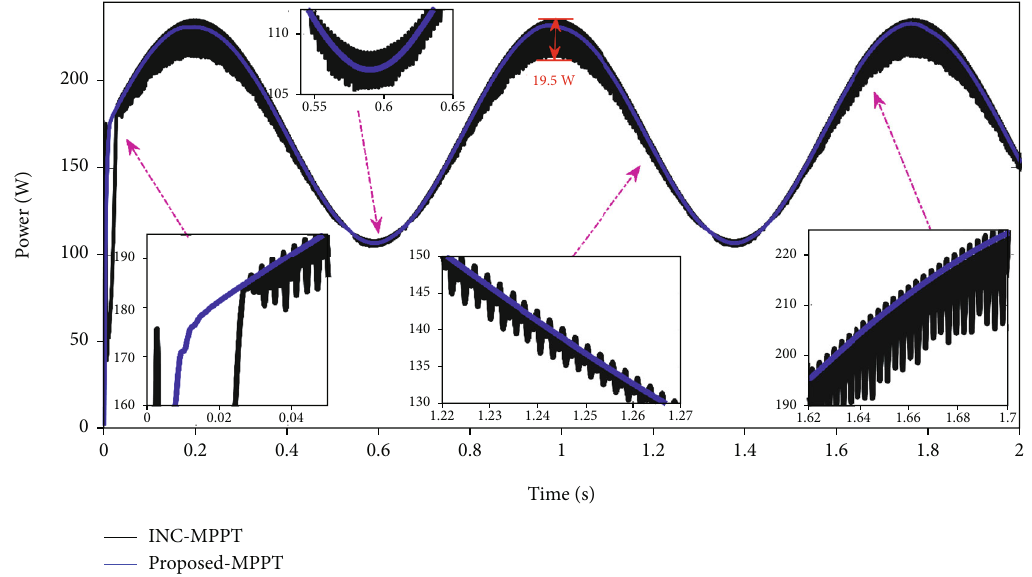
Figure 18: Photovoltaic output power curves of INC and the proposed MPPT schemes.